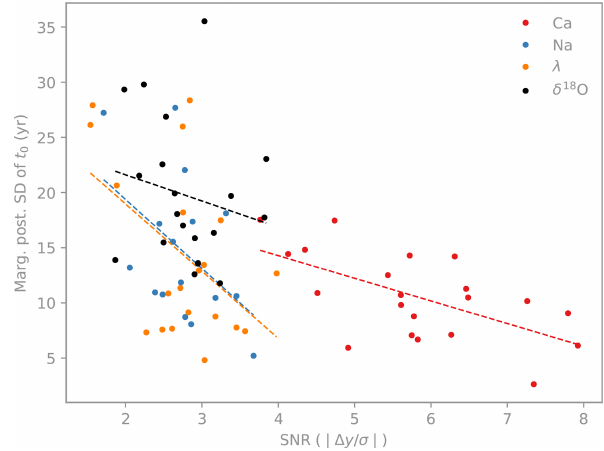
Figure A1. Timing uncertainty as a function of SNR for the NGRIP datasets. The uncertainty in the onset of the transition increases with lower SNR, as defined by the amplitude of the transition over the amplitude of the noise. Note that the linear fits are only for illustra- tion.